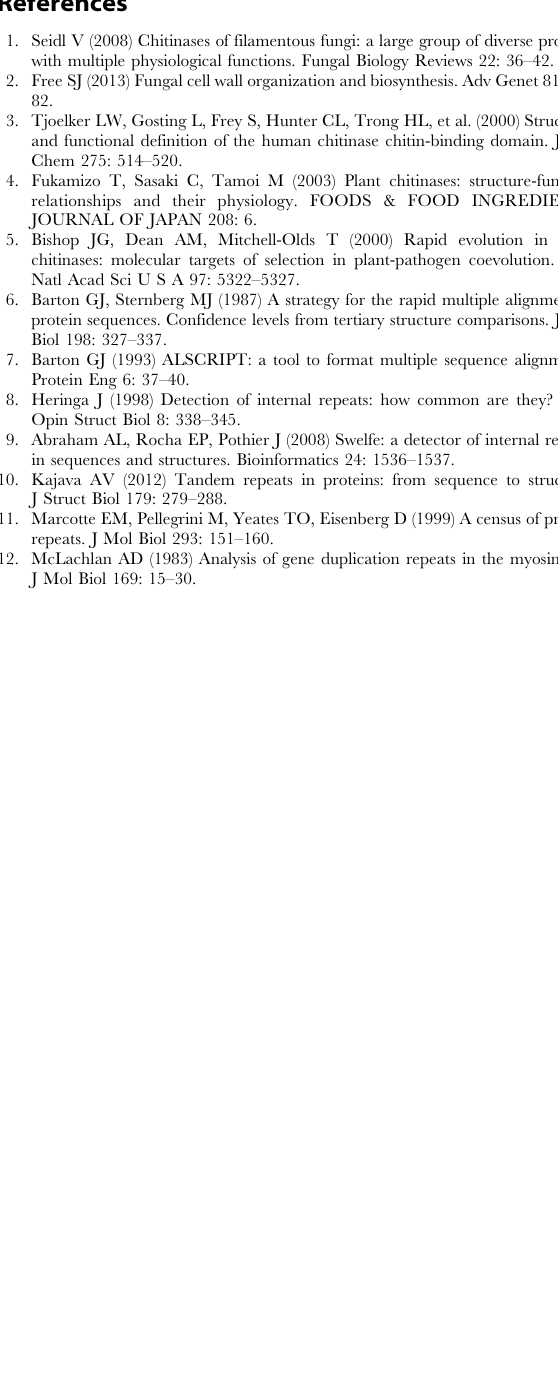
Table S3 RMSD and Z-scores of structural superposition of proteins belonging to the Endochitinase fold.